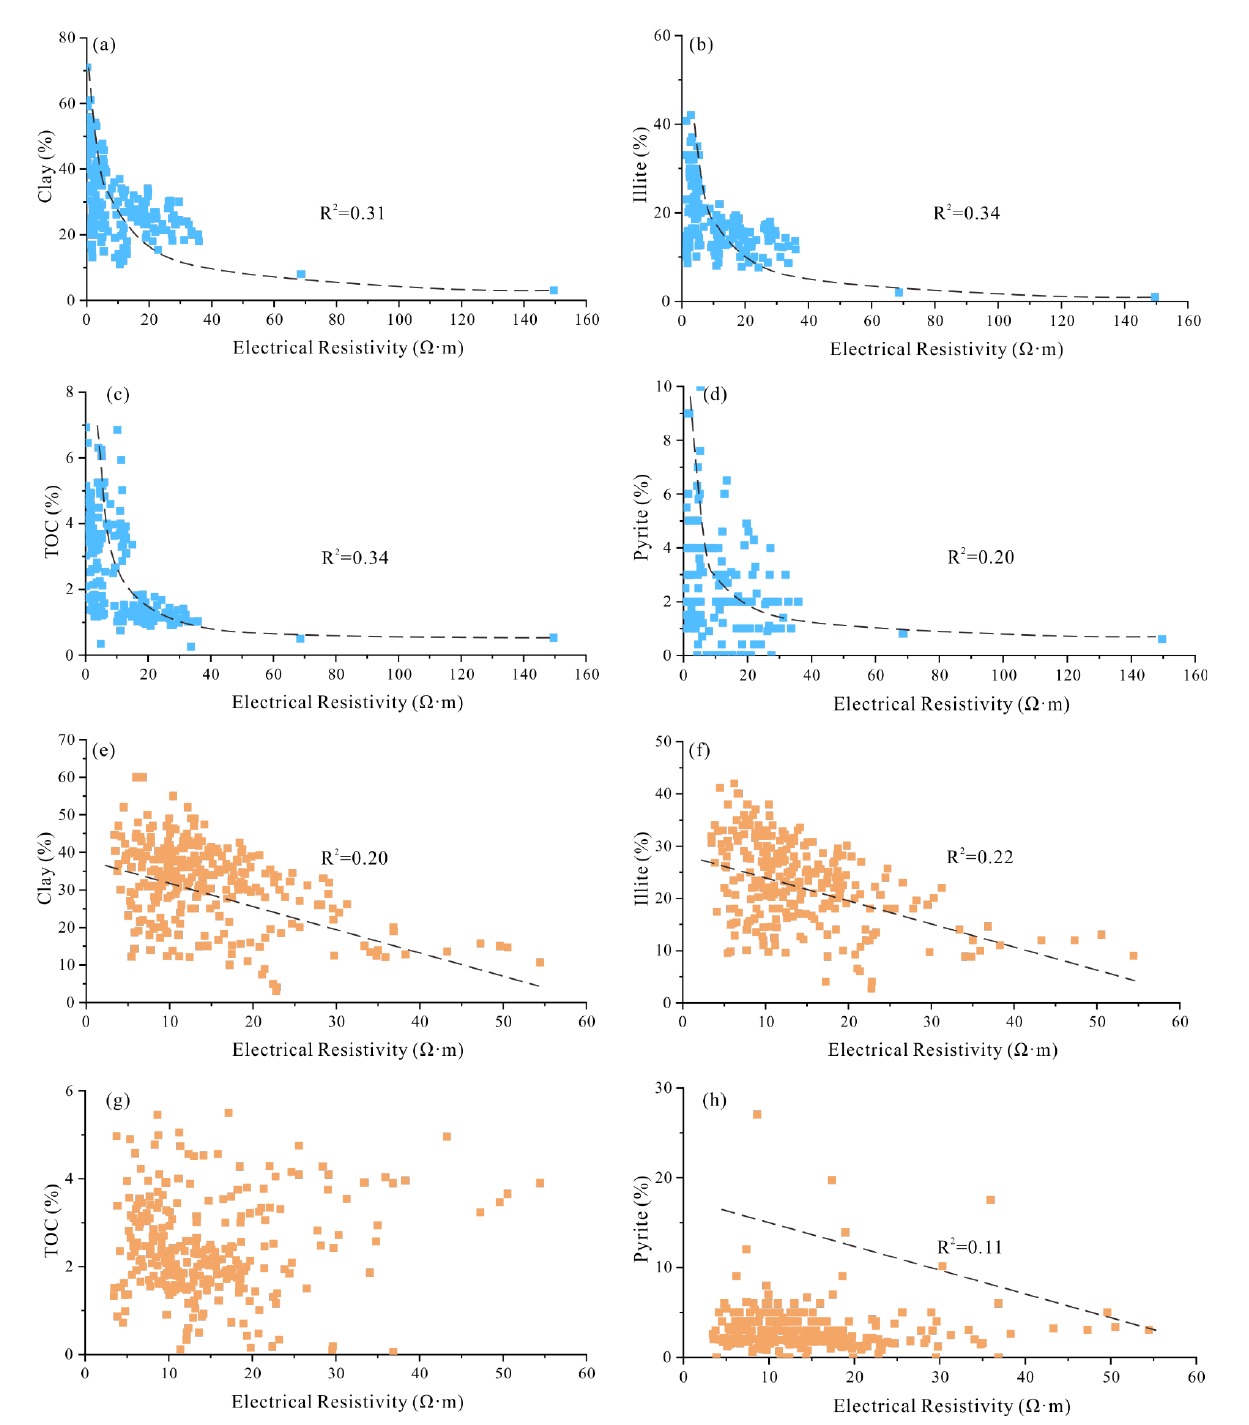
Figure 7. Core photographs, thin section photos and SEM images of gravity flow deposits in the Southern Sichuan Basin. ( a ) Massive shale with wavy siltstone laminae developed in core, 4243.9 m, L4 well, ( b ) lenticular debris aggregates mixed with dark organic matter, thin section photo, 4243.9 m, L4 well, ( c ) xenomorphic clastic clays filled in the primary pore, SEM image, 4243.9 m, L4 well, ( d ) typical eroded cross bedding observed from core, 2320.9 m, N2 well, ( e ) coarse silt mixed with terrigenous clay scours and erodes underlying argillaceous deposits in thin sections, 2320.9 m, N2 well, ( f ) disordered flake-like illite in primary pores.